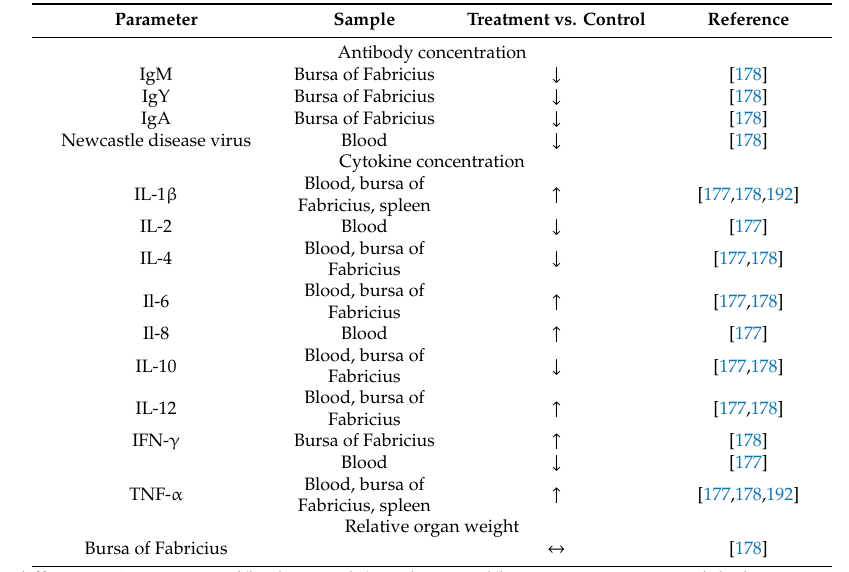
Table 5. Alterations of immune parameters of chickens exposed to hydrogen sulfide (H 2 S) (treatment) compared to control